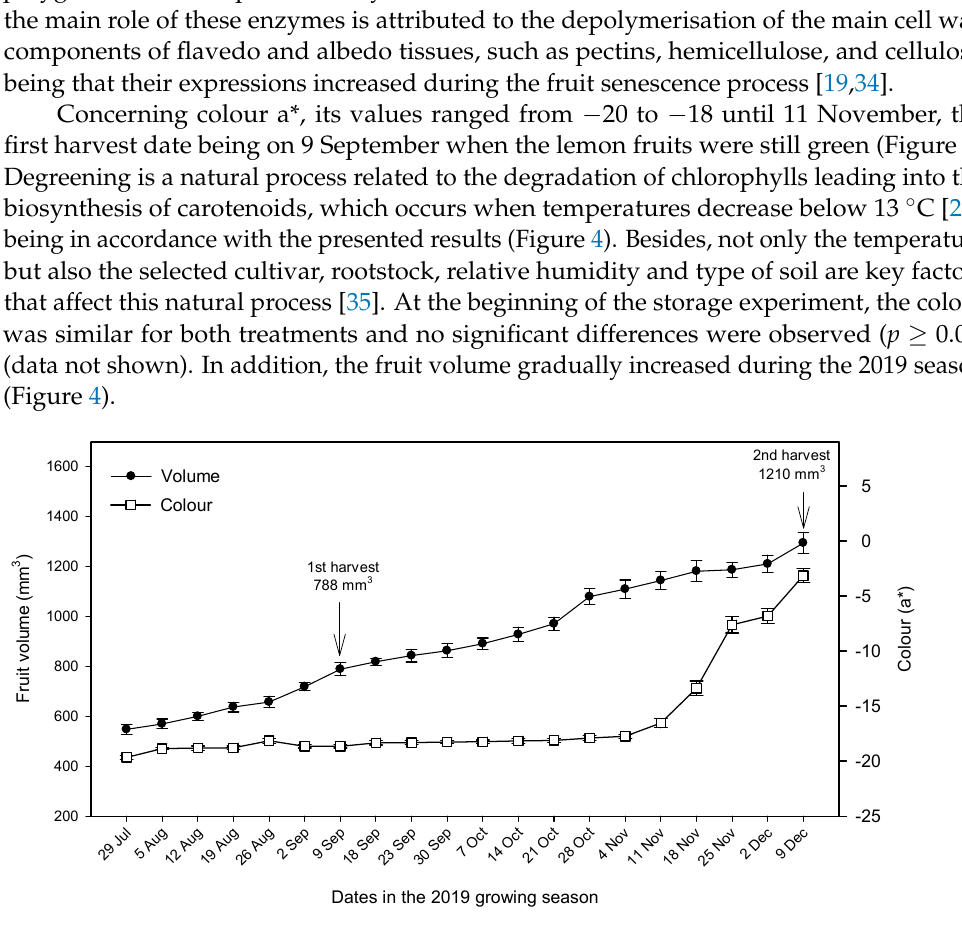
* Figure 5. Effect of degreening treatment on total soluble solids ( A ), titratable acidity ( B ), and total phenolic content in flavedo ( C ) and juice (D ) in lemon fruits stored for 28 days at 10 °C. Asterisks (*) show significant differences between treated and non-treated fruits at p < 0.05. Differences between both treatments on TSS and TA content observed at harvest (Fig- ure 5A,B, respectively) could be related to the evolution of these physico-chemical param-